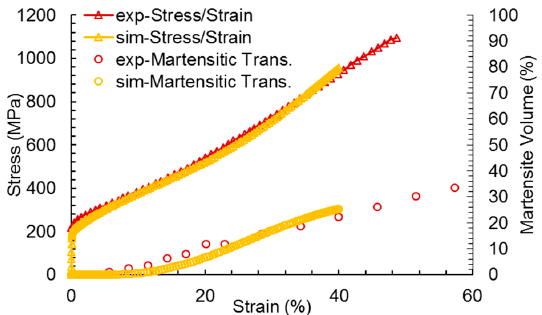
( b ) Figure 14. Experimental results of cast X8CrMnNi16-6-6 steel: ( a ) flow curve and martensitic transformation data measured by Fisher ferritoscope; ( b ) stress/strain plot with consolidated in situ acoustic emission test data (reprinted with permission from [46], Elsevier, 2013). Numerical simulation results of the calibrated material model are compared with the